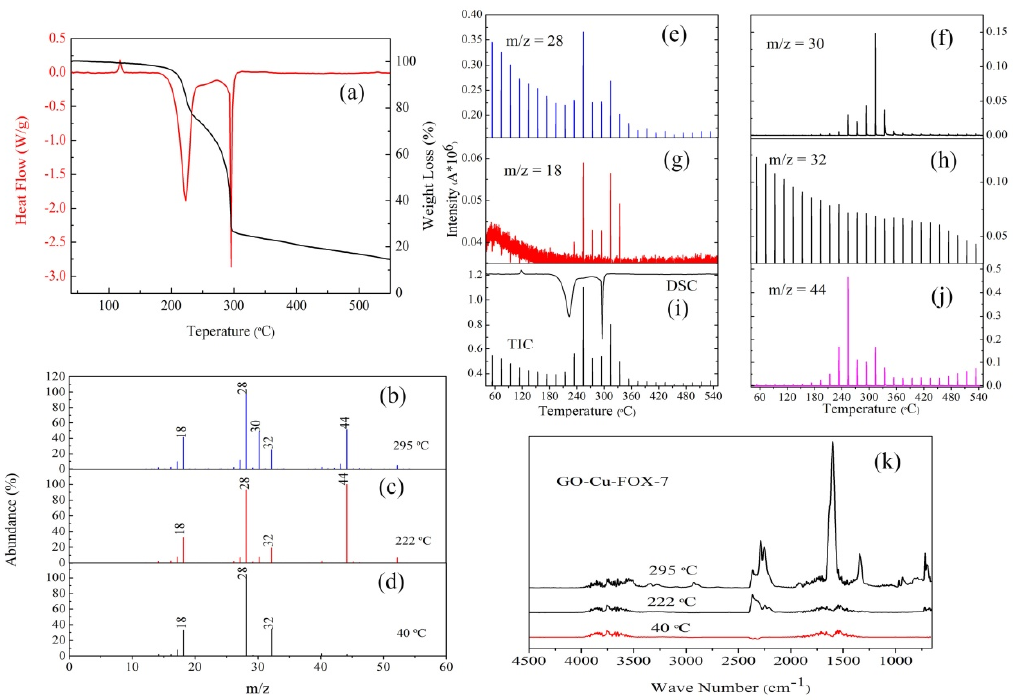
Nanomaterials 2019 , 9 , x FOR PEER REVIEW 12 of 16 The decomposition products of nGO-Fe-FOX-7 are similar to that of nGO-Cu-FOX-7 (Figure 11). However, based on the ion current of m/z = 30 it is known that the generation of NO is higher in nGO- Figure 10. ( a ) DSC and TG curves of nGO-Cu-FOX-7 with heating rate of 10 ◦ C / min; the MS spectra of Figure 10. ( a ) DSC and TG curves of nGO-Cu-FOX-7 with heating rate of 10 °C/min; the MS spectra Fe-FOX-7. This may be because the coordination effect of Fe 3+ with nGO is higher. Therefore, the nGO-Cu-FOX-7 at ( b ) 295 ◦ C, ( c ) 222 ◦ C and ( d ) 40 ◦ C; the ion current spectra of nGO-Cu-FOX-7 in the of nGO-Cu-FOX-7 at ( b ) 295 °C, ( c ) 222 °C and ( d ) 40 °C; the ion current spectra of nGO-Cu-FOX-7 in thermal decomposition of FOX-7 proceeds more thoroughly, which are consistent with the DSC decomposition with ( e ) m / z = 28, ( f ) m / z = 30, ( g ) m / z = 18, ( h ) m / z = 32, ( i ) total ion current, ( j ) m / z = 44; the decomposition with ( e ) m/z = 28, ( f ) m/z = 30, ( g ) m/z = 18, ( h ) m/z = 32, ( i ) total ion current, ( j ) m/z result. The decomposition process of nGO-Fe-FOX-7 was shown in (6) of Scheme 1. ( k ) IR spectra of nGO-Cu-FOX-7 at 295 ◦ C, 222 ◦ C and 40 ◦ C. = 44; ( k ) IR spectra of nGO-Cu-FOX-7 at 295 °C, 222 °C and 40 °C.